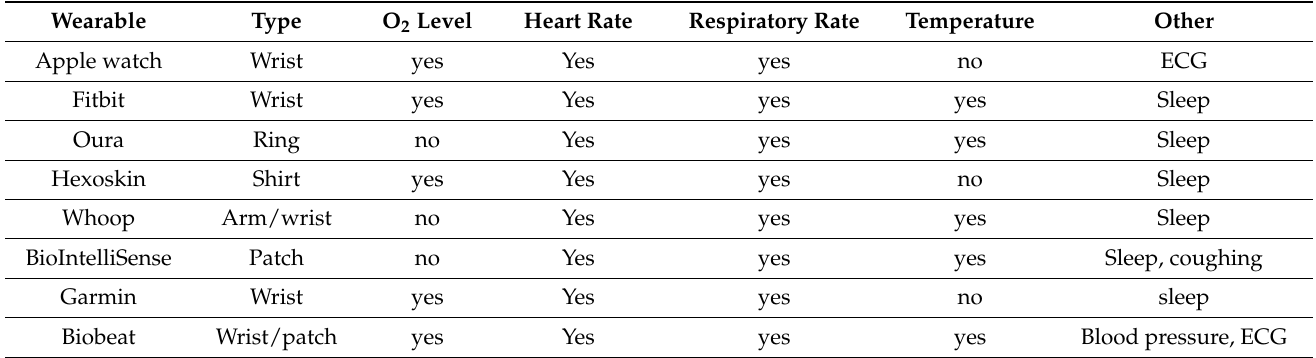
Table 1. Some of the commercial wearables for biometric measurements. ECG: electrocardiogram, O 2 :